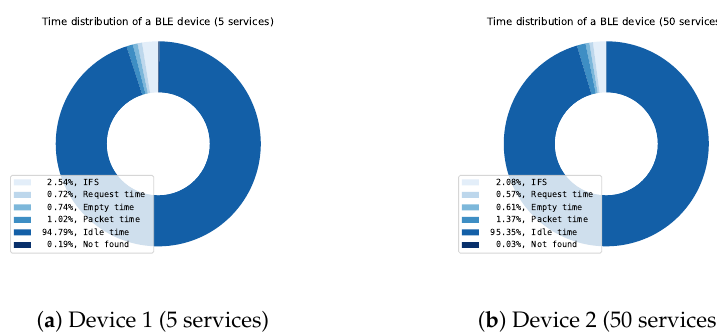
Figure 12. Time distribution of the discovery process of two devices: ( a ) Device 1 and ( b ) Device